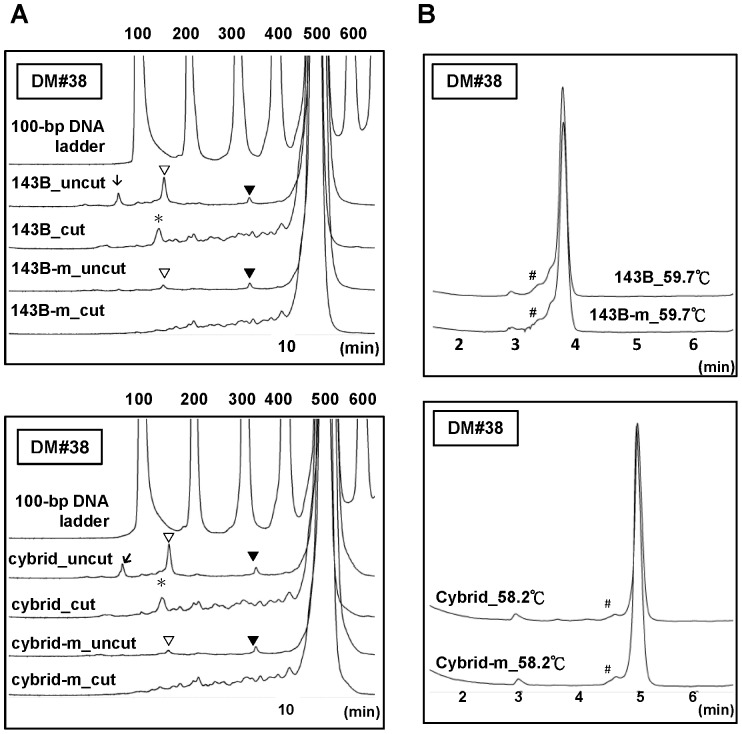
Results from SN/WAVE-HS and DHPLC analysis of the DM#38 amplicon by using total DNA and mtDNA from cells.(A) Results from SN/WAVE-HS analysis. (B) Results from DHPLC analysis. The upper and lower panels of Figure 6A and Figure 6B display the results for 143B cells and the cybrid cells, respectively. In Figure 6A, the results for the DNA samples without (uncut) and with (cut) SN digestion were also compared. ▾ indicates the peaks that appeared in the chromatograms of uncut DNA but were not observed in the chromatograms of the corresponding cut DNA for all DNA samples. ▽ indicates the peaks >100 bp only present in the chromatograms of the uncut DNA of both total DNA and mtDNA (m), but not the cut DNA. Such peaks for the mtDNA were considerably smaller than those of total DNA. ↓ indicates the peaks <100 bp that were present in the chromatograms of the uncut total DNA but absent in those of the uncut mtDNA. The patterns of peaks in the chromatograms from uncut DNA and cut DNA displayed marked differences. The chromatograms of the cut DNA samples displayed numerous small peaks. One obvious peak (indicated by *) appeared for the cut DNA of whole cells but was absent for mtDNA. In Figure 6B, the small but identifiable heteroduplex peaks detected by DHPLC are indicated by #.